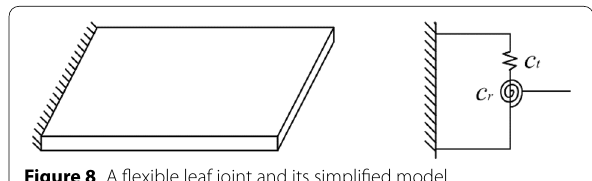
Figure 8 A flexible leaf joint and its simplified